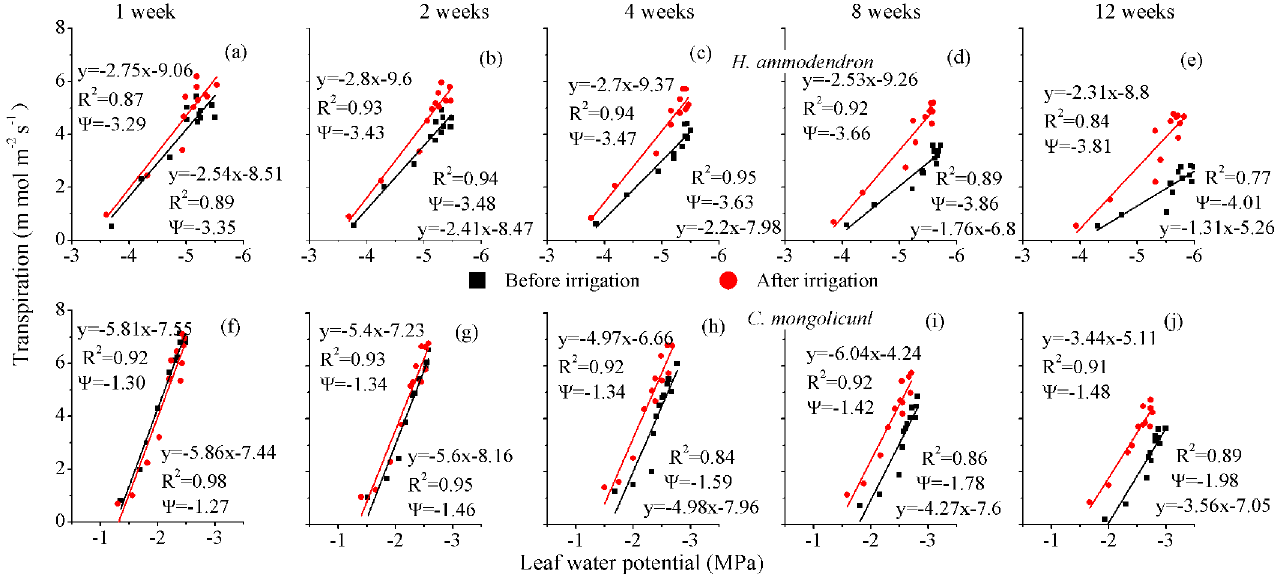
Fig 7. Leaf-specific apparent hydraulic conductance of Haloxylon ammodendron (a–e) and Calligonum mongolicunl (f–j) before and after irrigation with intervals of 1, 2, 4, 8 and 12 weeks. The relationshipbetweenleaf water potentialand transpirationrate was best fitted by the linear function Y = A + BX, in which A represents Ψ 0 which is the water potentialat the soil–-rootinterface and B representsleaf-specific apparenthydraulic conductance before and after irrigation.